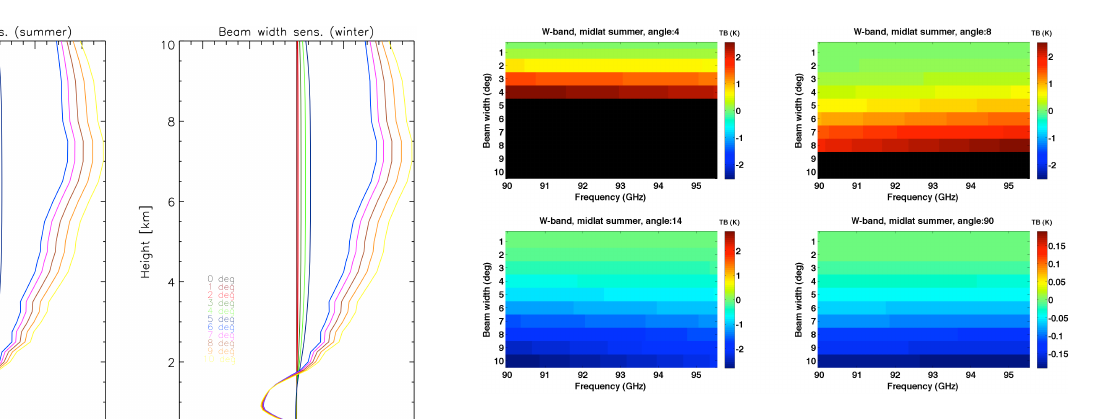
Fig. 16. The errors associated to the antenna beam width effect in Figure 16. The errors associated to the antenna beam width effect in differential TB for W-5 differential TB for W-band frequencies using the mid-latitude sum- band frequencies using the mid-latitude summer atmospheric profile. The TB differences are 6 mer atmospheric profile. The TB differences are defined as the TB defined as the TB calculated from a forward model without beam width minus the TB 7 calculated from a forward model without beam width minus the TB calculated from a forward model with beam width. Black area at calculated from a forward model with beam width. Black area at elevations 4° and 8° are 8 elevations 4 ◦ and 8 ◦ are when the beam at least partially hits the when the beam at least partially hits the ground. 9